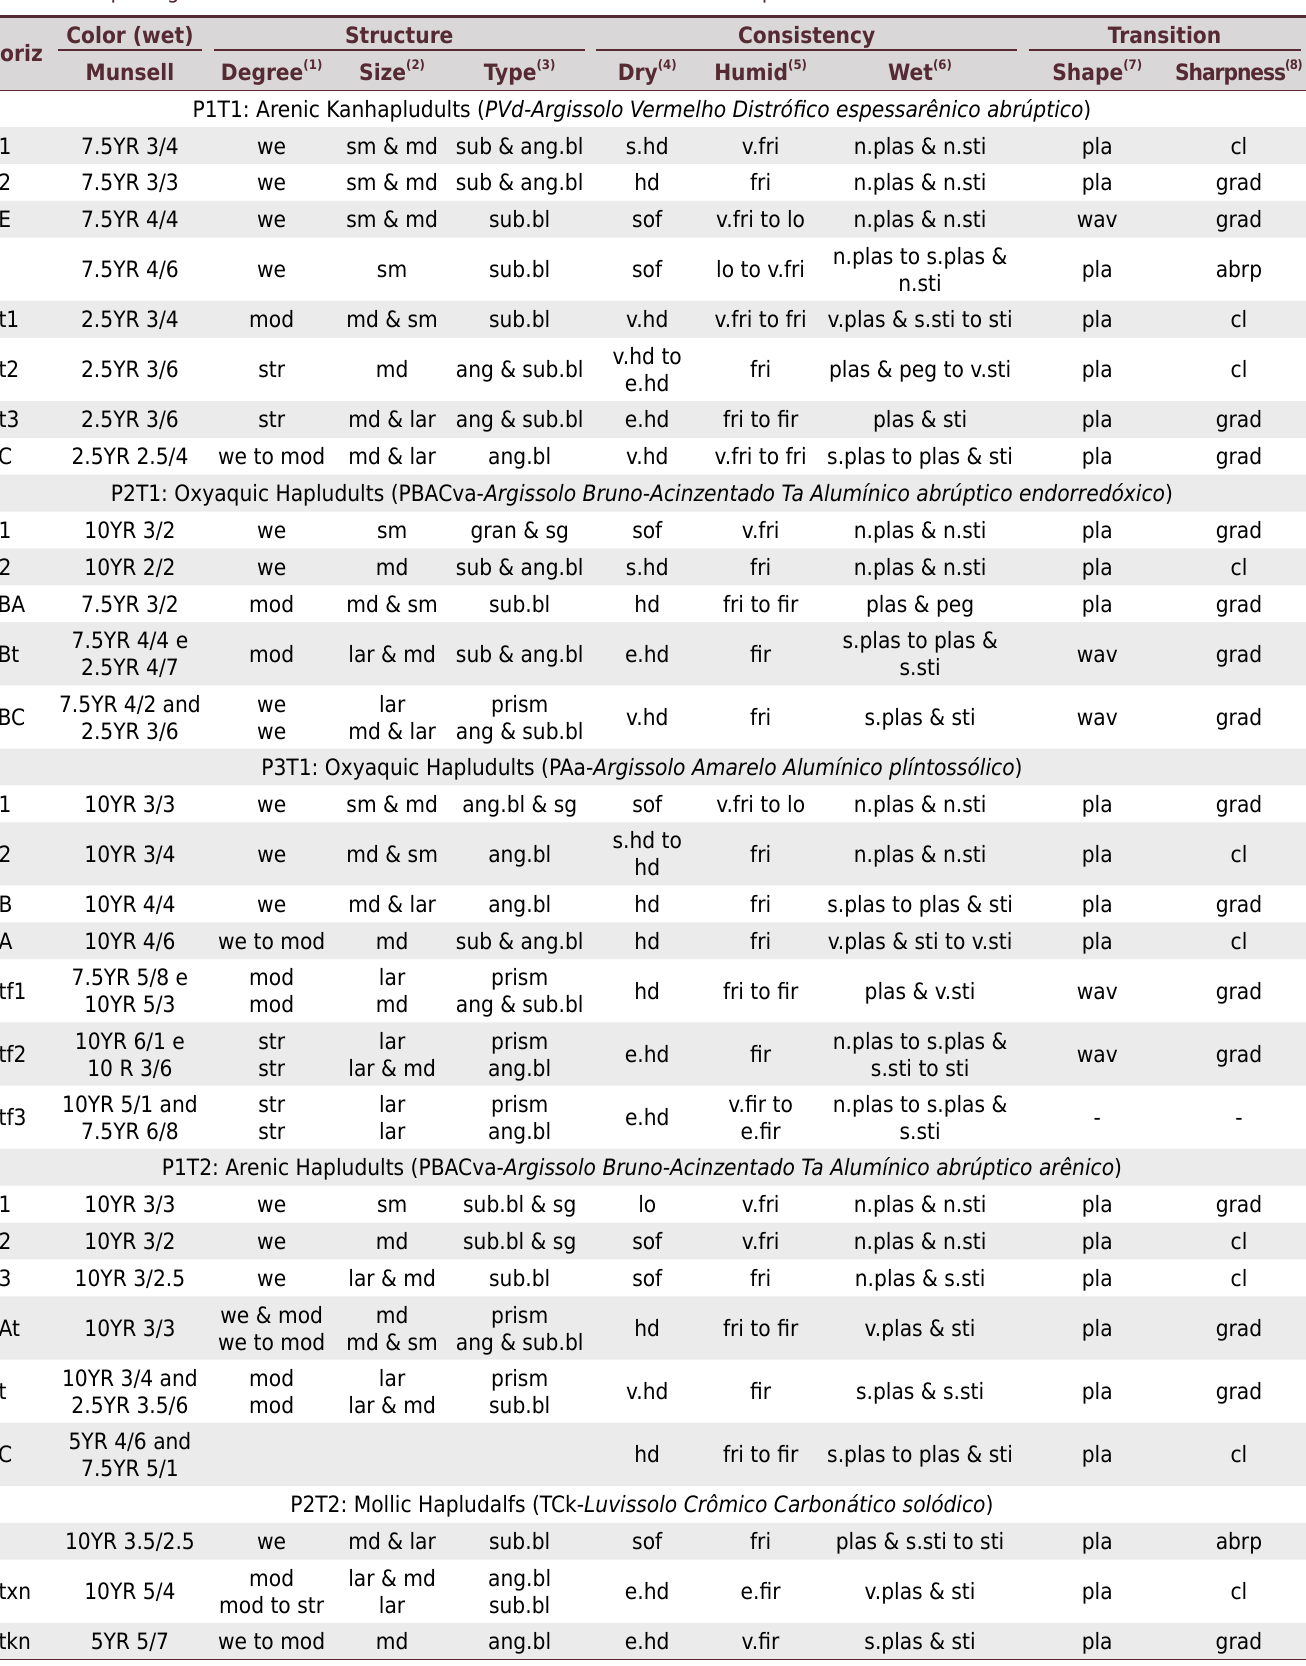
Table 1. Morphological characterization of the soil in horizons of the studied profiles Color (wet) Structure Horiz